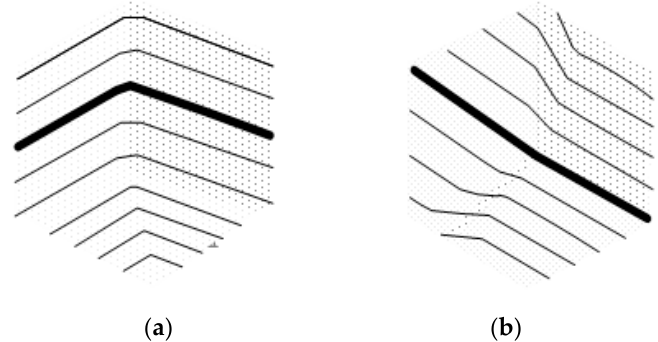
Figure 5. The Influence of the Relative Position of Geodesic Curve and Surface Boundary on Subsequent Trajectory.